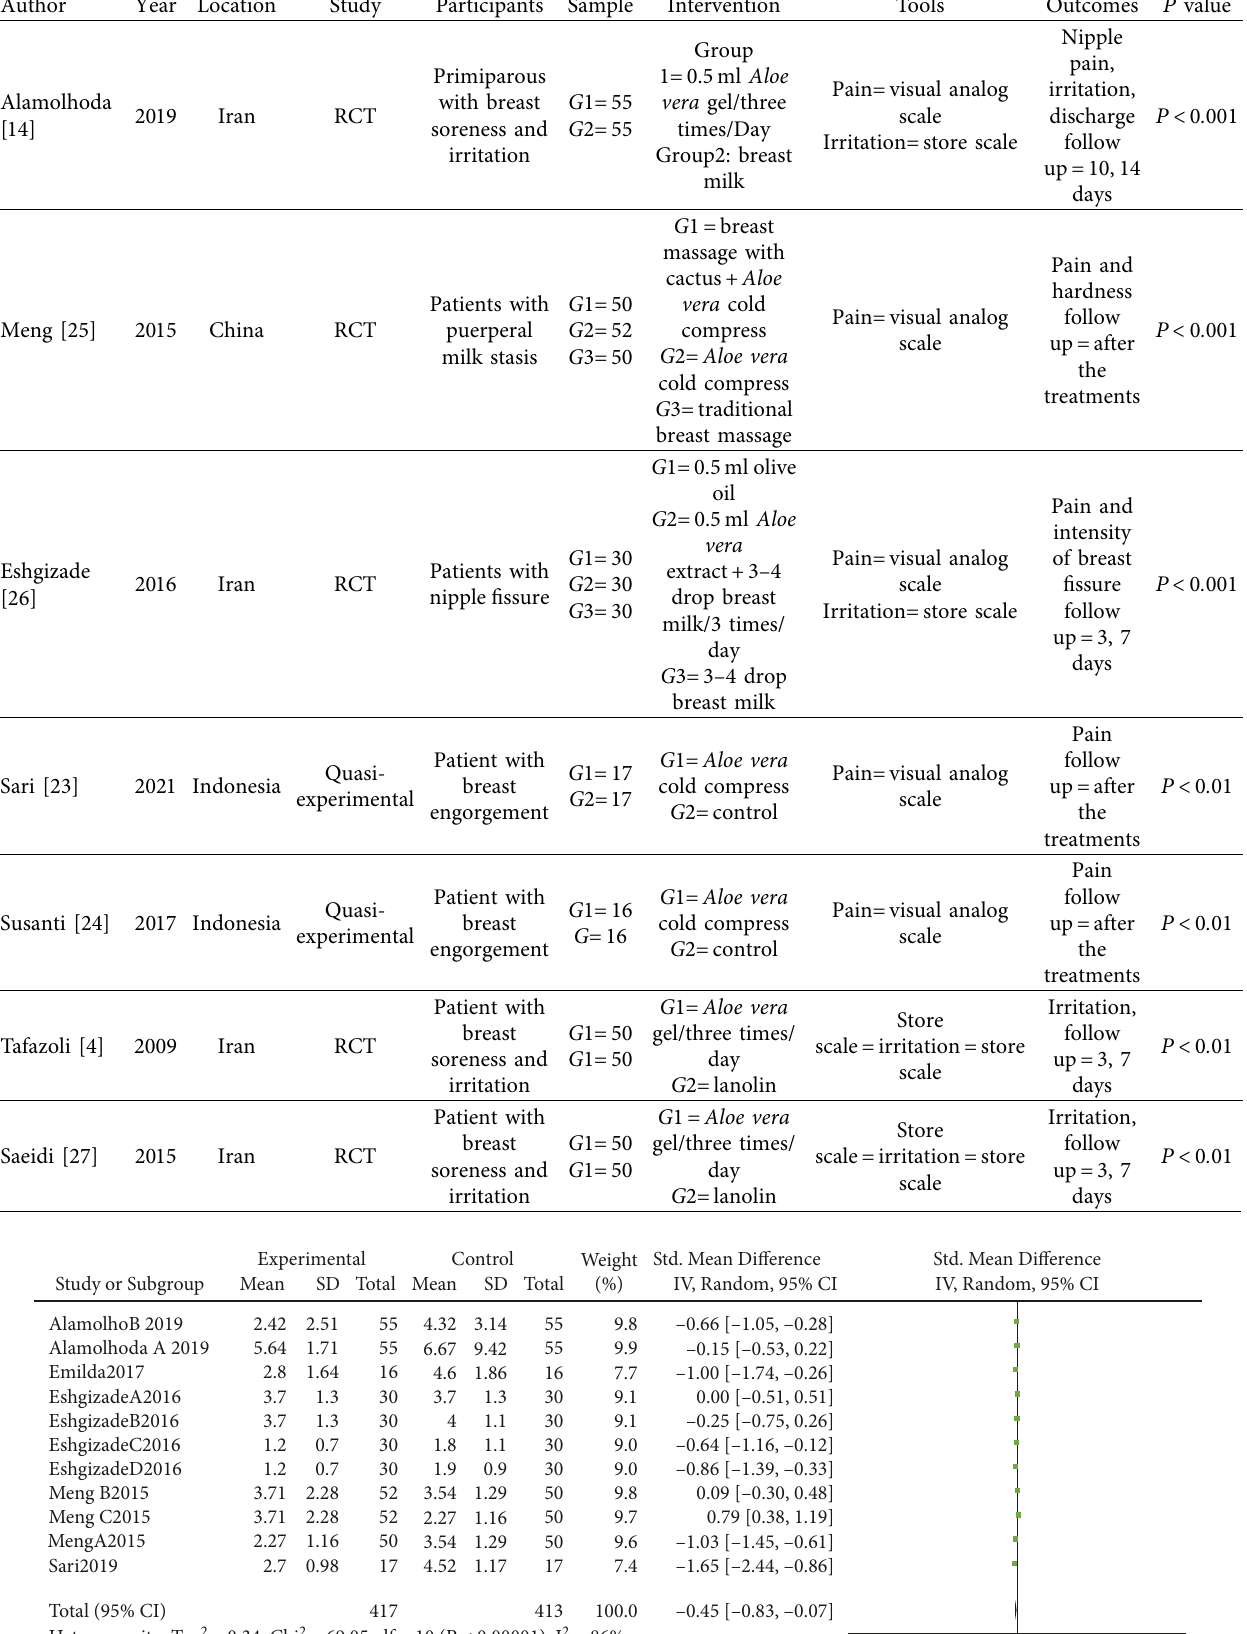
Table 1: Characteristics of studies included in the systematic review.